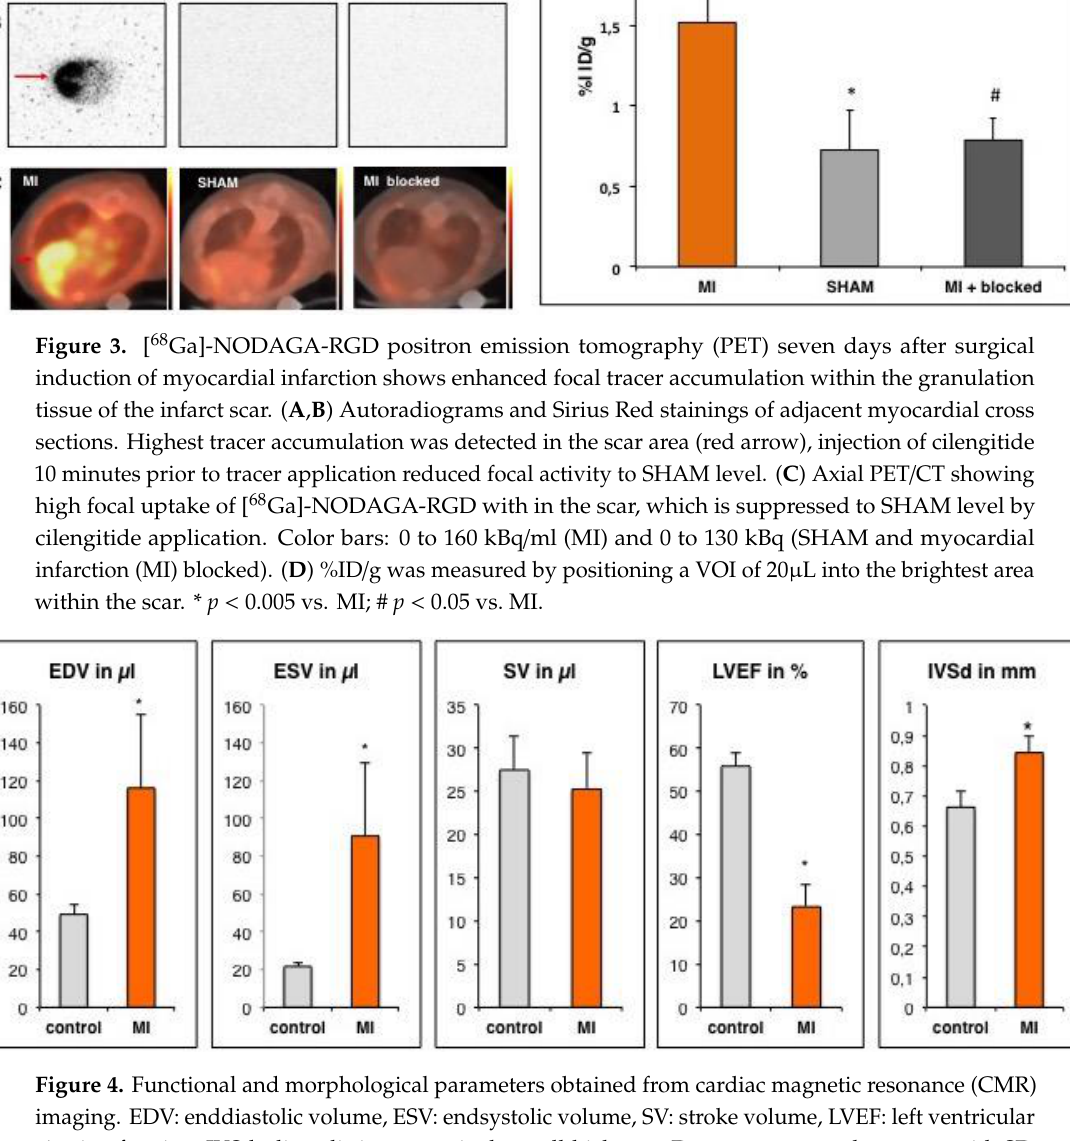
Figure 3. [ 68 Ga]-NODAGA-RGD positron emission tomography (PET) seven days after surgical induction of myocardial infarction shows enhanced focal tracer accumulation within the granulation tissue of the infarct scar. ( A , B ) Autoradiograms and Sirius Red stainings of adjacent myocardial cross sections. Highest tracer accumulation was detected in the scar area (red arrow), injection of cilengitide 10 minutes prior to tracer application reduced focal activity to SHAM level. ( C ) Axial PET/CT showing high focal uptake of [ 68 Ga]-NODAGA-RGD with in the scar, which is suppressed to SHAM level by cilengitide application. Color bars: 0 to 160 kBq/ml (MI) and 0 to 130 kBq (SHAM and myocardial infarction (MI) blocked). ( D ) %ID/g was measured by positioning a VOI of 20µL into the brightest area within the scar. * p < 0.005 vs. MI; # p < 0.05 vs. MI .